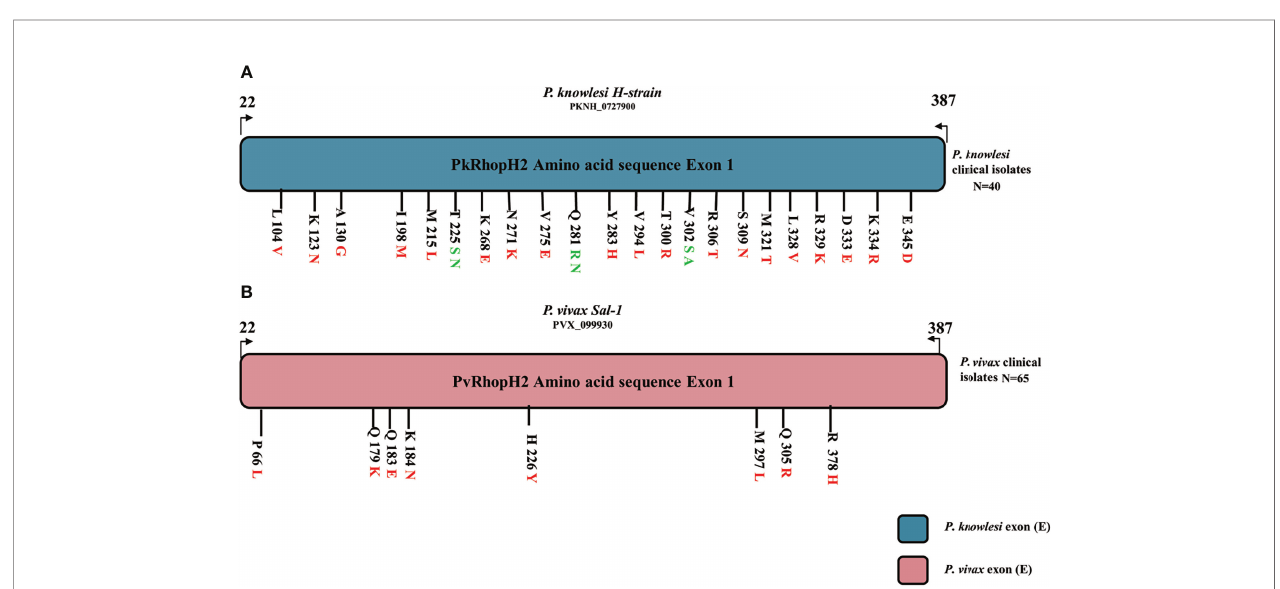
FIGURE 3 | (A) Schematic representation of amino acid polymorphism in clinical isolates in P. knowlesi RhopH2 protein. Amino acid polymorphism is represented by black lines with letter and numbers. The letter before number represents the reference H-strain amino and polymorphism is represented in red (two variants) and green color (three variants). Similarly in P. vivax clinical samples in (B). The alphabet letter represents the amino acid one-letter code, and numbers represent amino acid